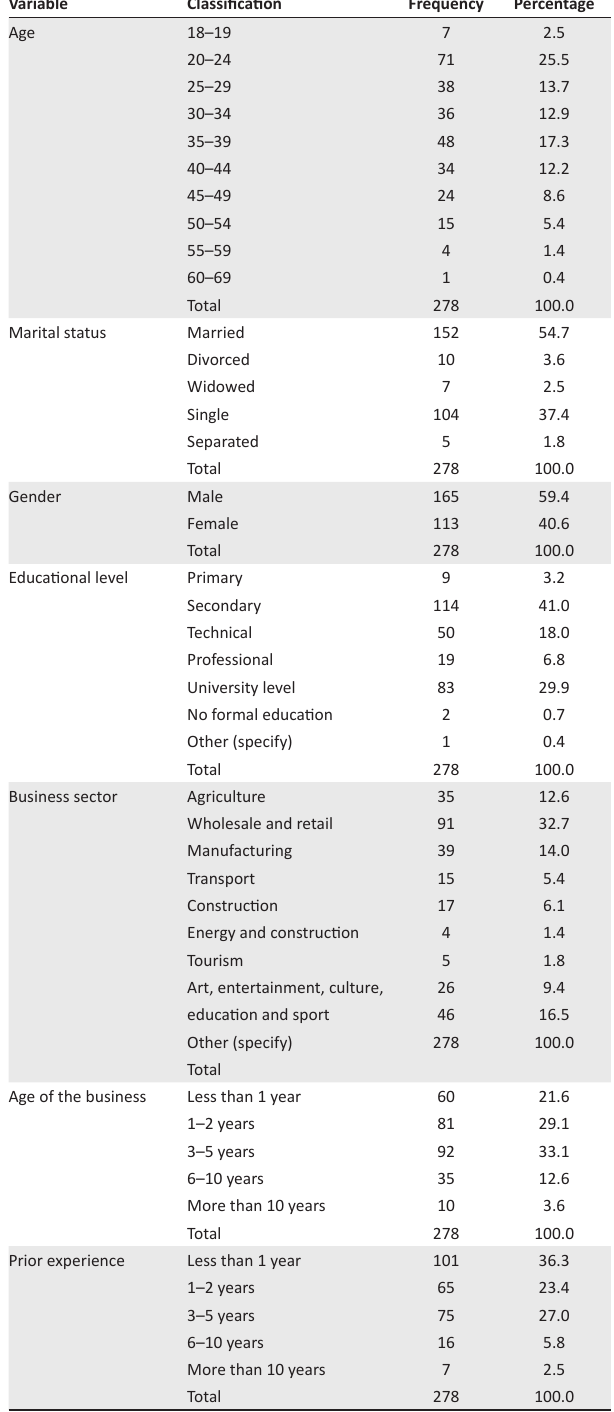
TABLE 2: Respondents’ demographic characteristics.